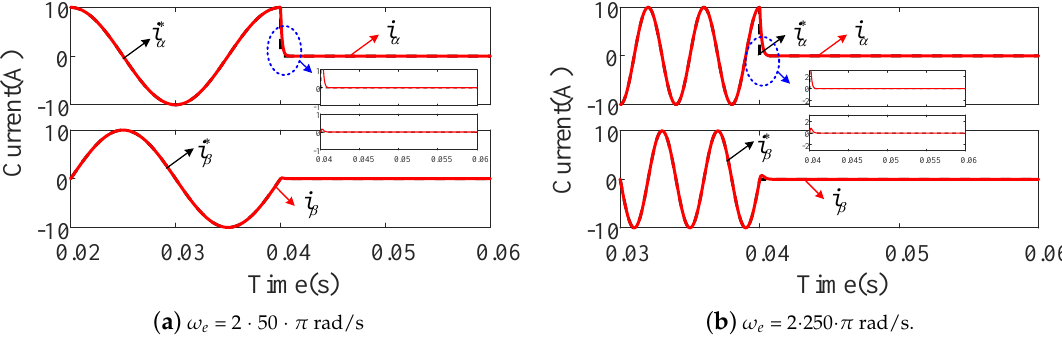
Figure 7. α -axis and β -axes current response with D-PCI